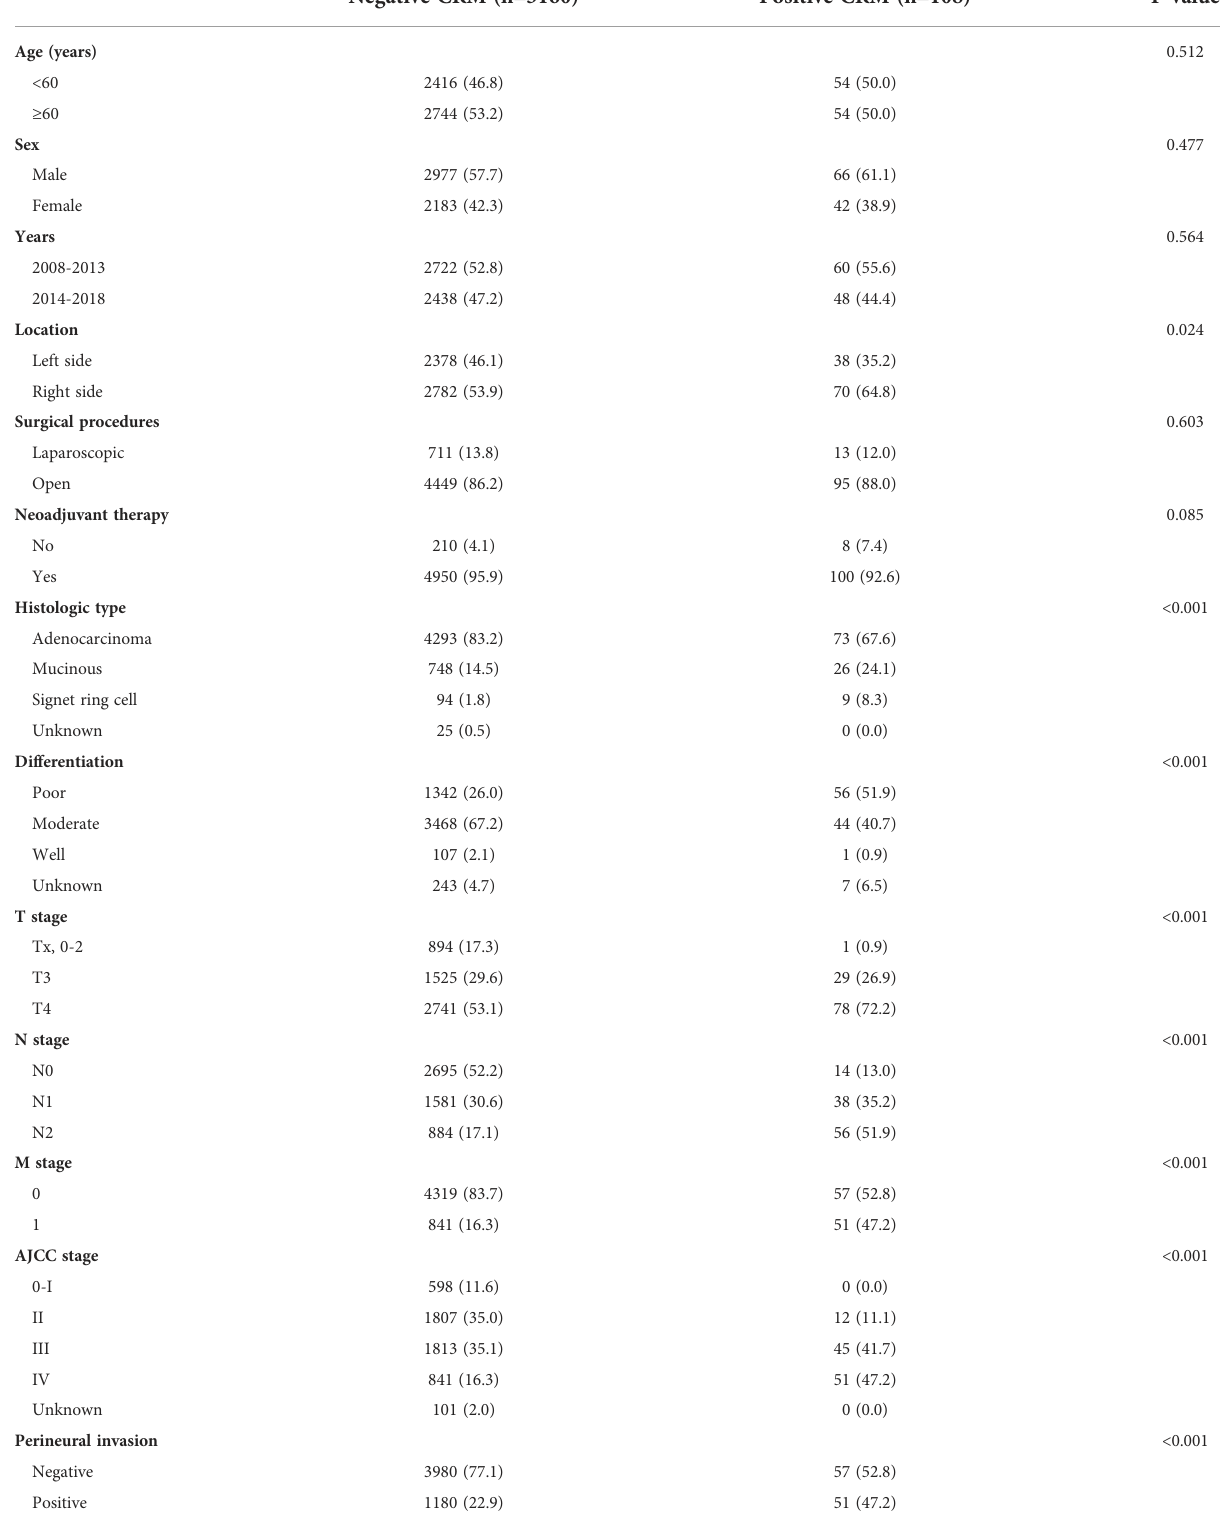
TABLE 1 Comparison of clinicopathological features according to CRM status before